Question: Identify the chart type used in this figure.
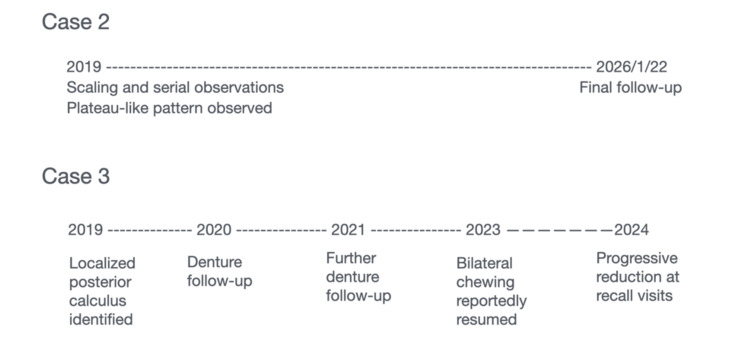
Answer: line